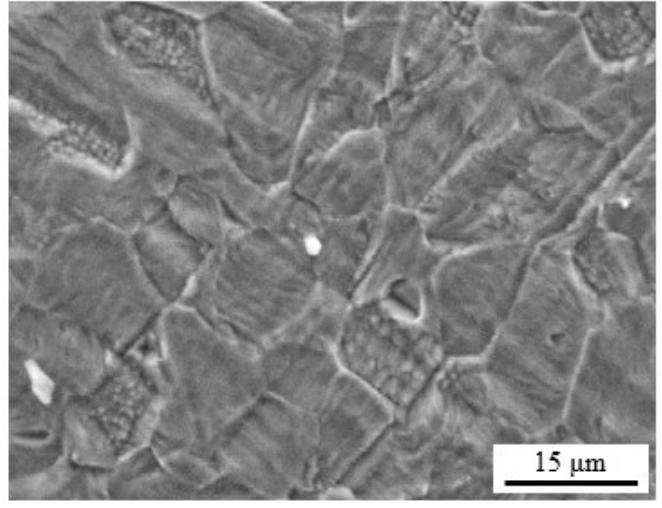
Figure 3. SEM micrograph of the recrystallized Fe − 30Mn − 5Al − 0.5C TWIP specimens.